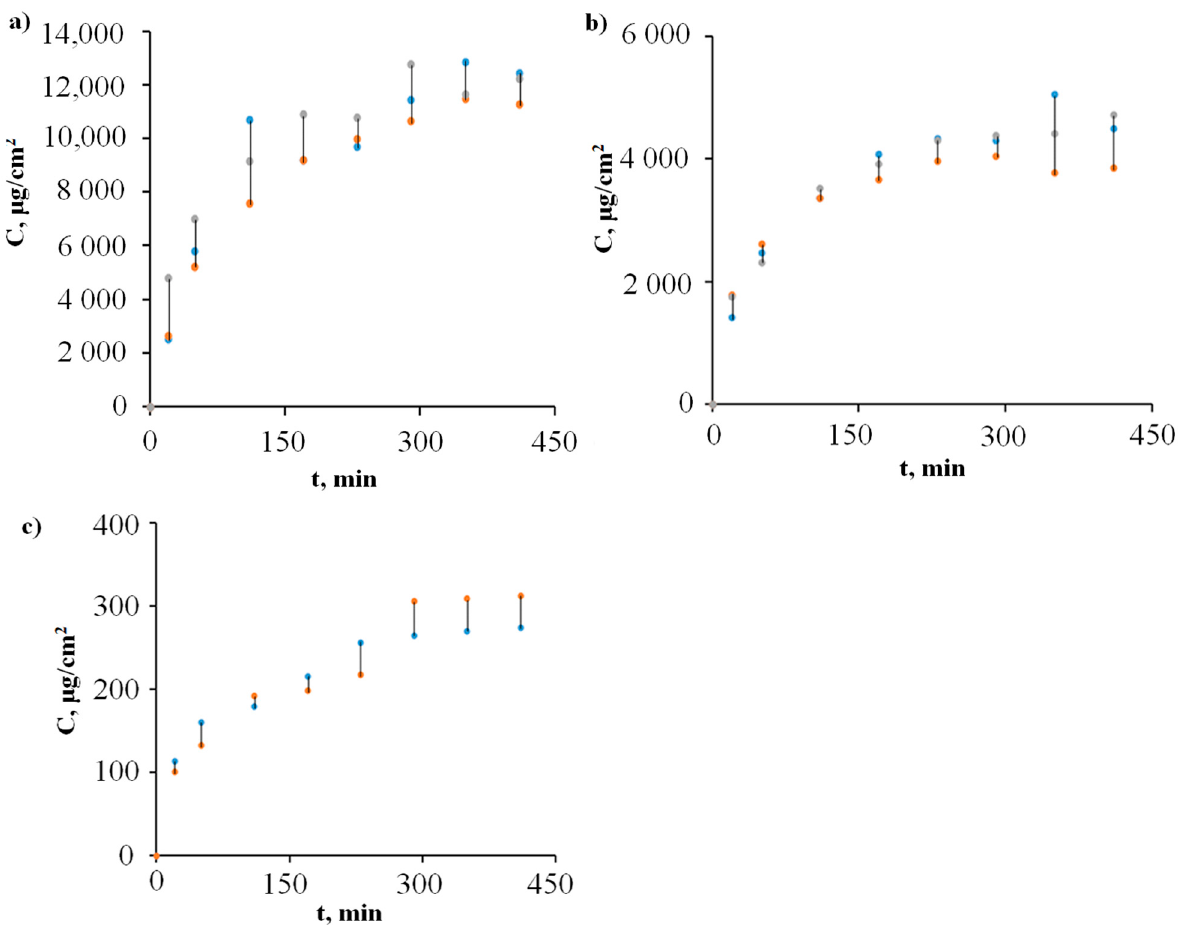
Figure 7. Dependence of xymedone permeability on the time through the acetyl cellulose membrane from ZnO NPs (0.1%)–Xym (5%) gel ( a ) and ZnO NPs (0.05%)–Xym (2.5%) gel ( b ). Dependence of Zn 2+ permeability (C Zn2+ , μ g/cm 2 ) on time through the acetylcellulose membrane from ZnO NPs (0.05%)–Xym (2.5%) gel ( c ). Gel weight was equal to 400 mg onto membrane. The area under gel was equal to 1.3 cm 2 .